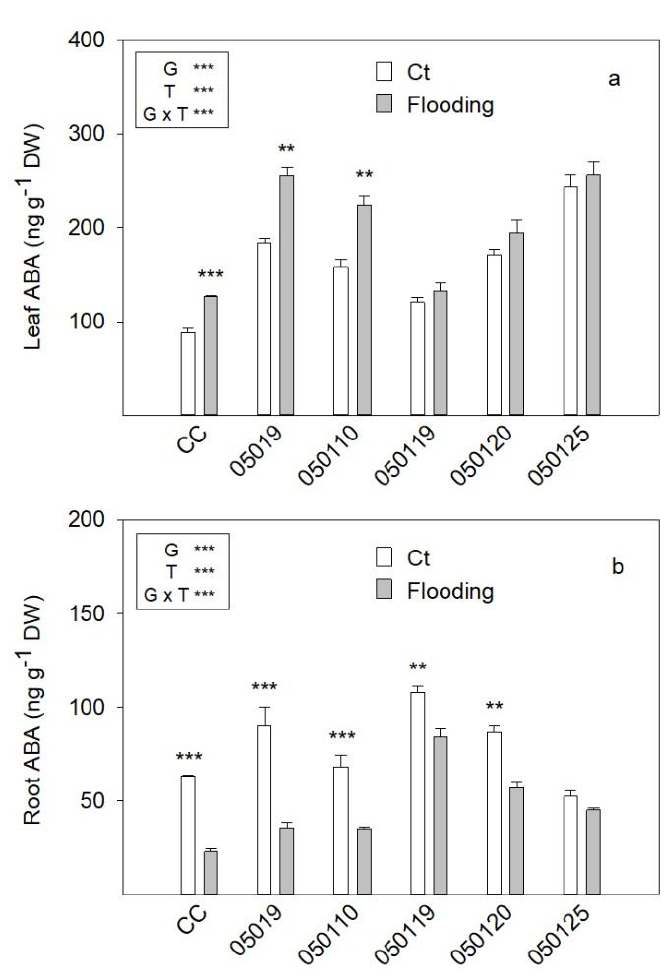
Figure 7. Abscisic acid concentration (ABA) in ( a ) the leaves and ( b ) roots of five citrus hybrids grown for 35 days in the non-stressed (Ct) or flooding treatment. Values are the means of six independent seedlings ( n = 6). In each hybrid, comparisons among treatments were made by Fisher’s least significance difference (LSD) test. ** p < 0.01, *** p < 0.001. CC: Carrizo citrange; G: genotype, T: treatment.